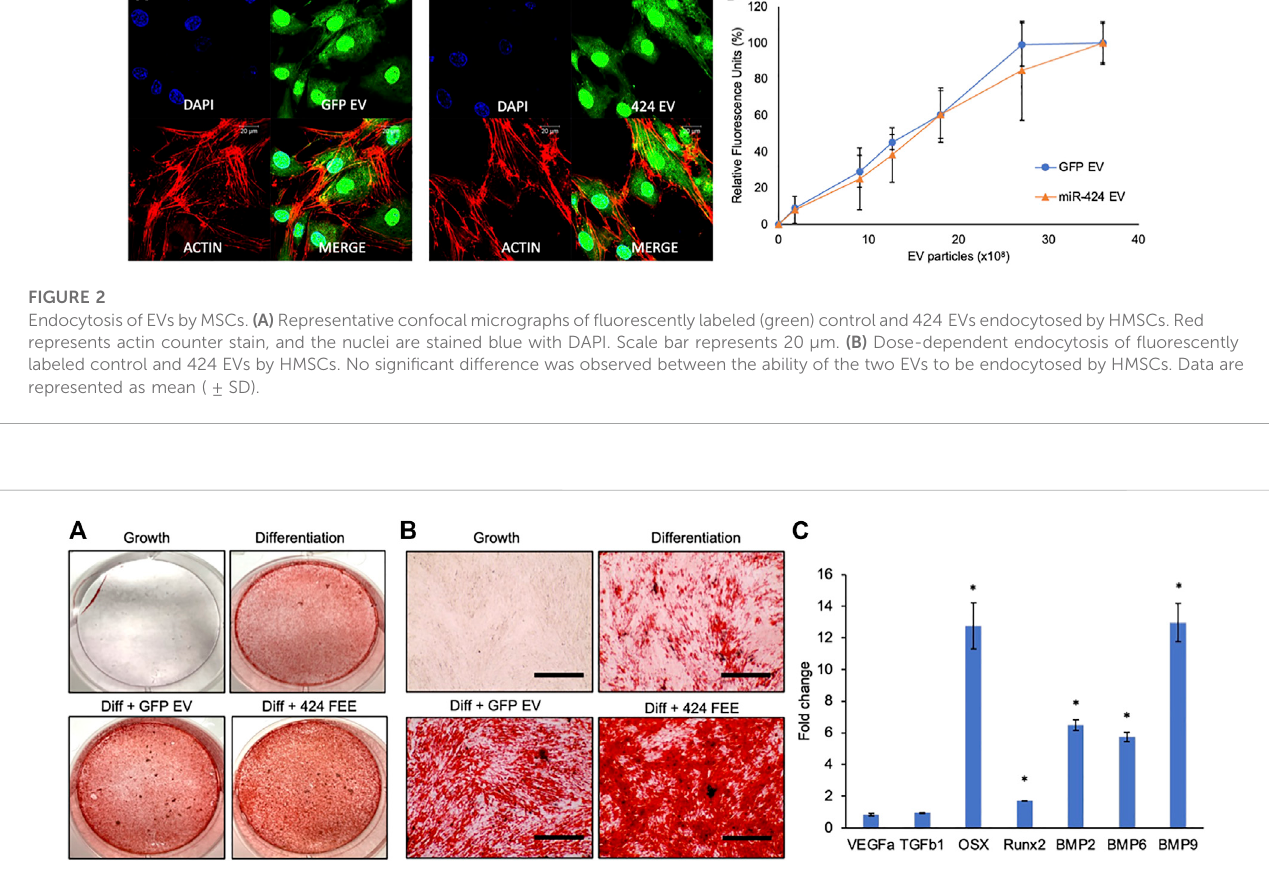
FIGURE 3 Osteoinductive property of the engineered EVs. (A) Macroscopic images of alizarin red stained HMSCs cultured for 14 days under the in fl uence of osteogenic differentiation medium with/without control or engineered EV supplementation to analyzecalcium deposition. Red staining denotes presence of calcium ions. Cells cultured under growth medium served as background control. (B) Microscopic (10x) images of the groups in (A) . Scale bar represents 100 μ m.NotetheincreasedpresenceofcalciumintheEVtreatedgroupsandthehighestlevelofcalciumpresenceinthe424 EVgroup. (C) Foldchange in expression levels of osteoinductive genes measured by qRT-PCR in 424 EV treated HMSCs (72 h post treatment) with respect to control group. Data are representedasmeanfoldchange( ± SD).*representsstatisticalsigni fi cancewithrespecttocontrolmeasuredbystudents t -test, p < 0.05.Notethesigni fi cant increase in the expression levels of osteoinductive growth and transcription